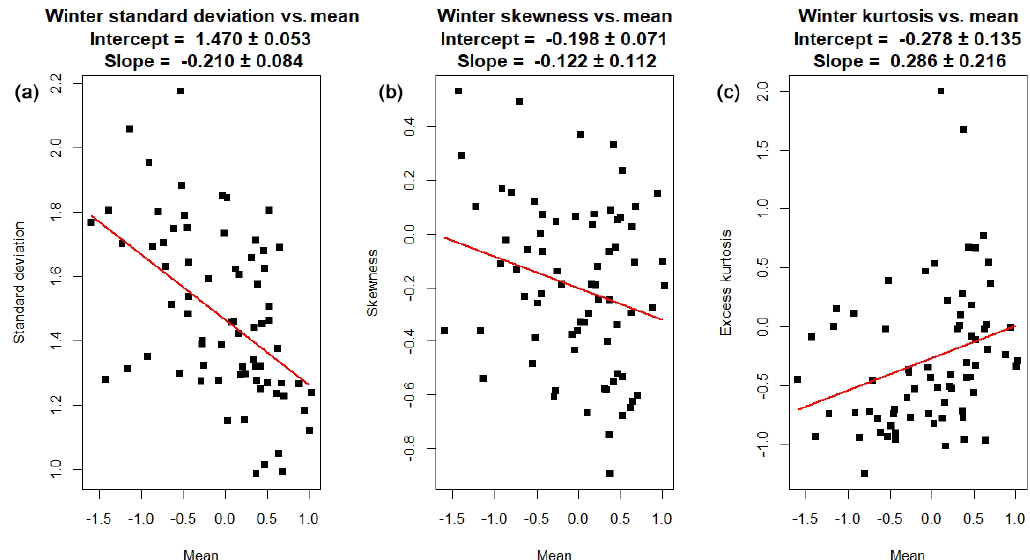
Figure 1. Relation between higher moments of the daily North Atlantic Oscillation (NAO) winter index and the sample mean for 71 winters. The plots show the sample standard deviation (a) , skewness (b) and excess kurtosis (c) as a function of the sample mean. The red lines are fitted regression lines. Point estimates and 95% confidence intervals for the intercepts and slopes of these lines are given above each plot.